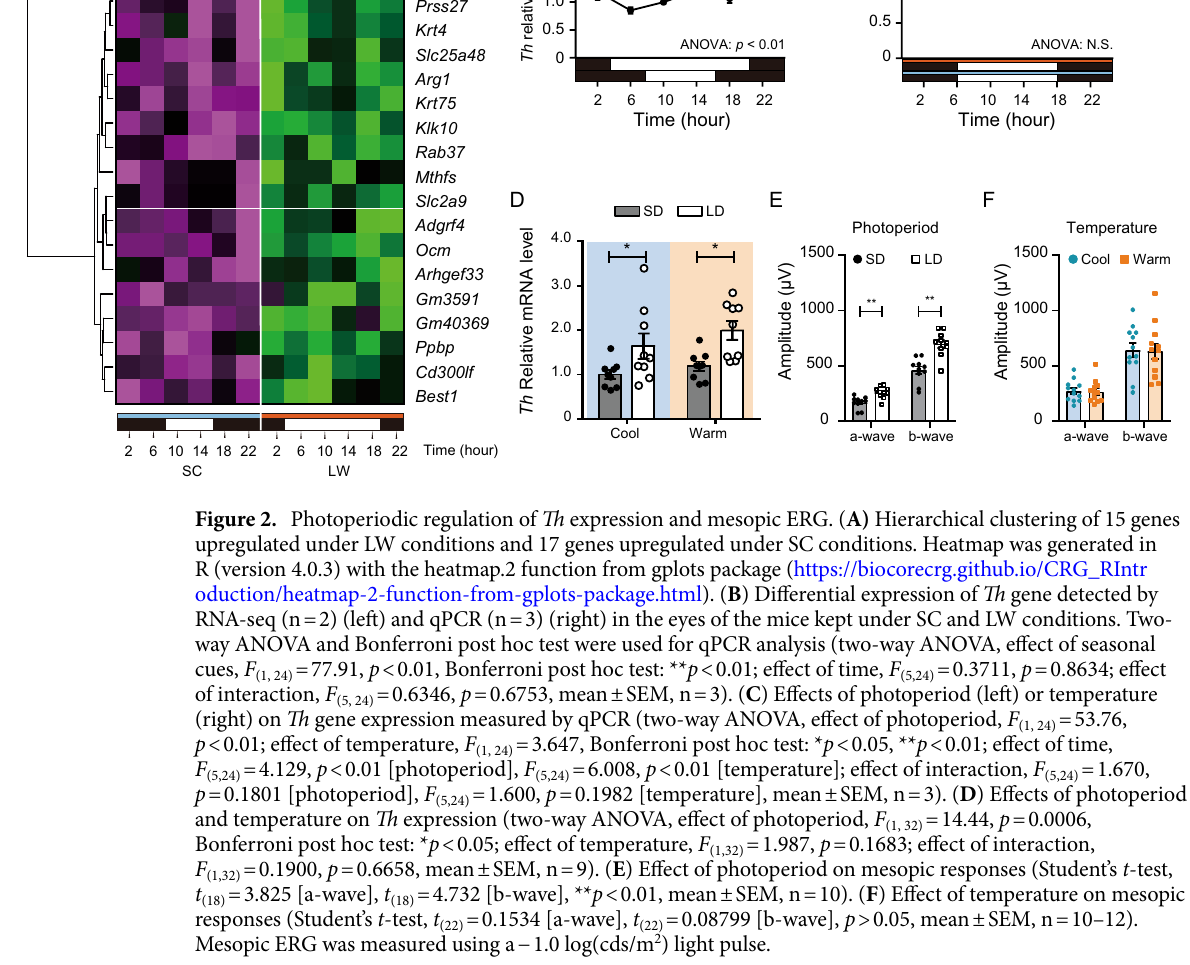
mice (Student’s t -test, p = 0.0214, n = 10; Fig. 3B). On the other hand, i.p. injection of a cocktail of antagonists for D1 and D4 receptors (SCH23390 and L-745870, 1 mg/kg each) 1 h before the ERG recording decreased b-wave amplitude in LD mice (Student’s t -test, p < 0.01, n = 12; Fig. 3C). The cAMP-responsive element (CRE) (TCA CGT CA) in the promoter region of Th is responsible for pro- moting basic and induced Th gene expression 23 , and phosphorylated CREB (pCREB) binds CRE to induce transcription. Western blotting revealed that the pCREB level in the eye was different between LD mice and SD mice (two-way ANOVA, p = 0.0477, n = 3; Fig. 3D, Supplementary Fig. S3). Modafinil inhibits dopamine reuptake 24 and engages the activation of pCREB 25 . Gavage administration of modafinil (64 mg/kg, 3 times per day for 3 days; Supplementary Fig. S4) improved b-wave amplitude (Student’s t -test, p = 0.0012, n = 10; Fig. 3E) and increased Th gene expression in the eyes of SD mice in vivo (Student’s t -test, p = 0.0469, n = 6; Fig. 3F). To